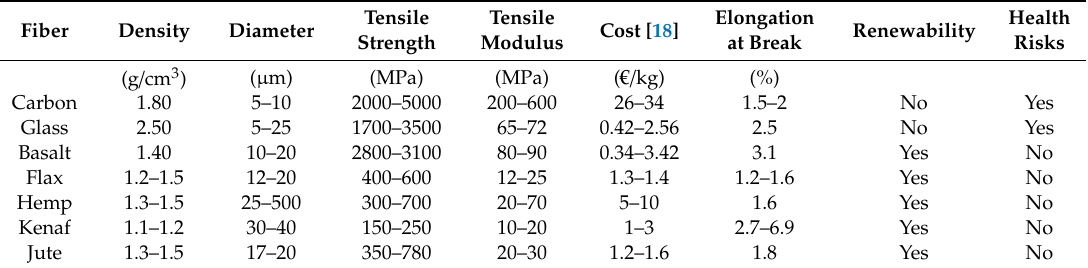
Table 1. Mechanical properties and sustainability characteristics of carbon, glass, basalt, and bast fibers [3,15–17]. The cost is based on public information